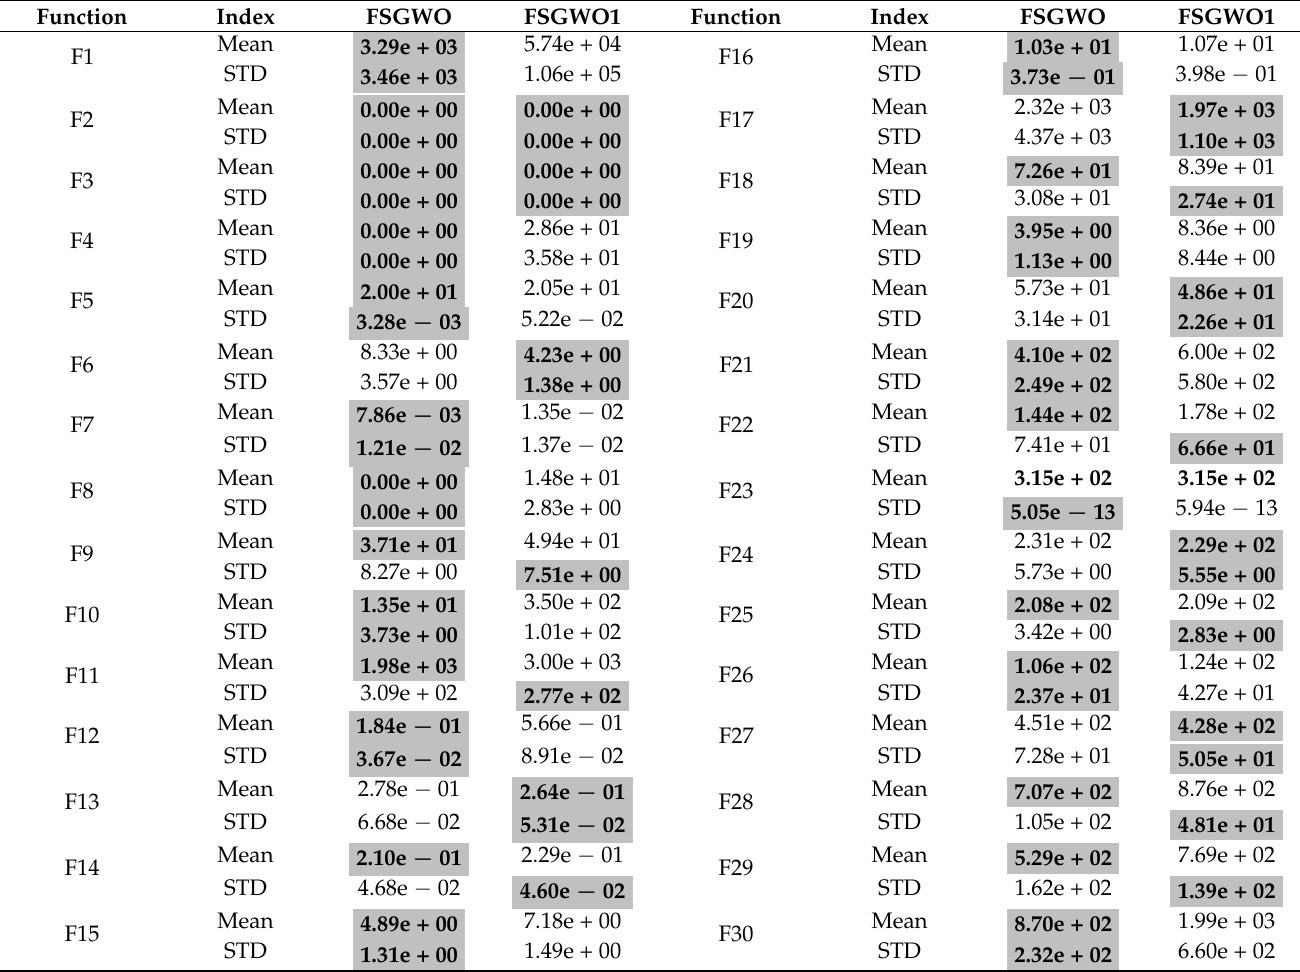
Table 8. Results of FSGWO and FSGWO1 for 30-dimensional